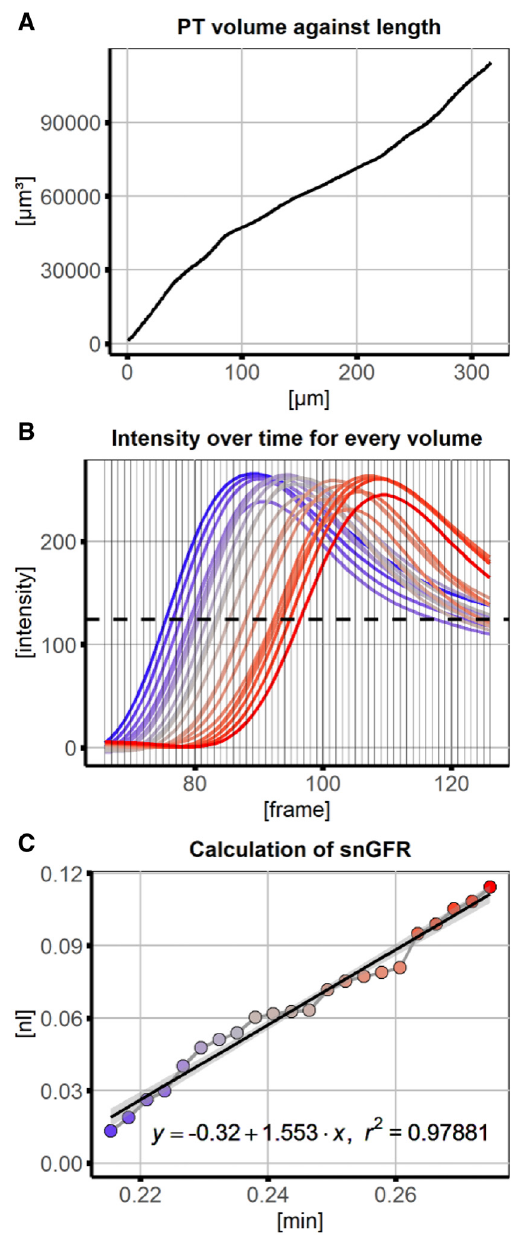
Figure 3. Data analysis and linear regression of signal volume against time for calcuation of glomerular filtration rate (GFR). A ) For every position along the line region of interest (ROI), the cumulative volume was measured, providing a conversion of position to volume. B ) Numerical data underlying the x-y plots was saved and used to subsequently plot changes of signal intensity over time for every position (and converted to cumulative volume) along the line ROI. The dashed line represents the threshold value at which the corresponding volume of the proximal tubule (PT) was approximated for every frame. C ) Using linear regression the snGFR could be calculated as the volume with the intensity threshold at the frames of interest (after conversion from µm³ per frame to nl per minute). Regression line is displayed with 95% confidence interval. The colour codes for the position along the PT (blue – beginning, red –